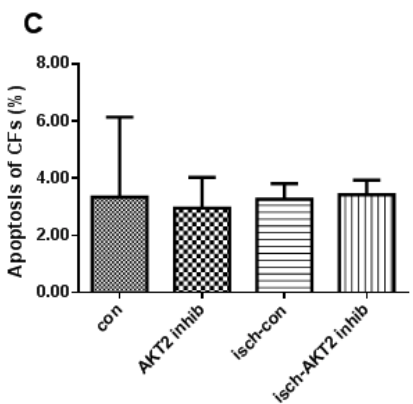
Figure 2. Increased apoptosis in cardiomyocytes treated with AKT2 inhibitor during ischemia. ( A ) Detection of Annexin V/Propidium iodide (PI) in cardiomyocytes treated with or without AKT2 inhibitor (AKT2-inhib, 10 µ M) and cultured under normal (con) or ischemia (isch) conditions for 12 h by flow cytometry; ( B ) TUNEL (transferase-mediated deoxyuridine triphosphate-biotin nick end labeling) assay of NRCMs with the same treatment as ( A ); ( C ) Quantification of apoptotic cardiomyocyte fibroblasts (CFs) treated with or without AKT2 inhibitor during ischemia by flow cytometry. Values are percentage of apoptotic cells versus total cells in plate. The bars represent the mean ± SEM (standard error of mean) of three independent experiments. * p < 0.05, ** p < 0.01 vs. control (one-way ANOVA followed by a Tukey test for post hoc analyses).